Question: Provide a one-line summary of what is displayed.
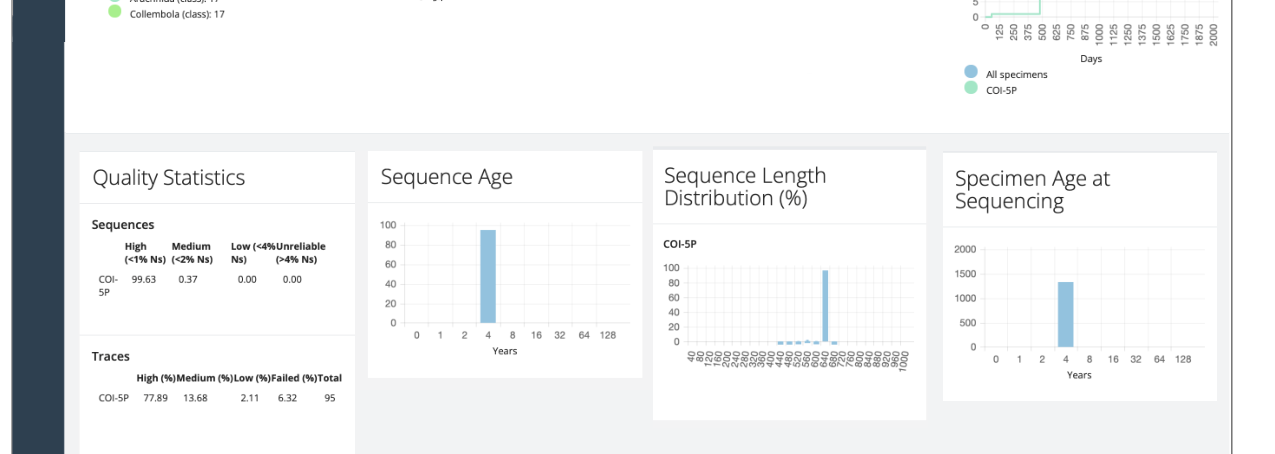
Answer: Project Console. The Project Console provides an overview of key metrics including the  number of specimens, sequences, and BINs associated with each project. It also displays important  statistics such as the success in sequence recovery, the BIN discordance rate, and a histogram of sequence  lengths. Finally, it highlights issues associated with records in the project.